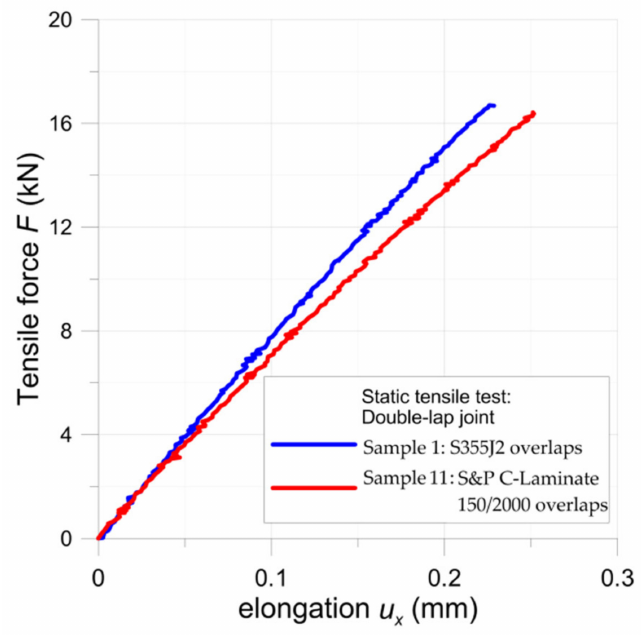
Figure 8. Tensile curves for double-lap